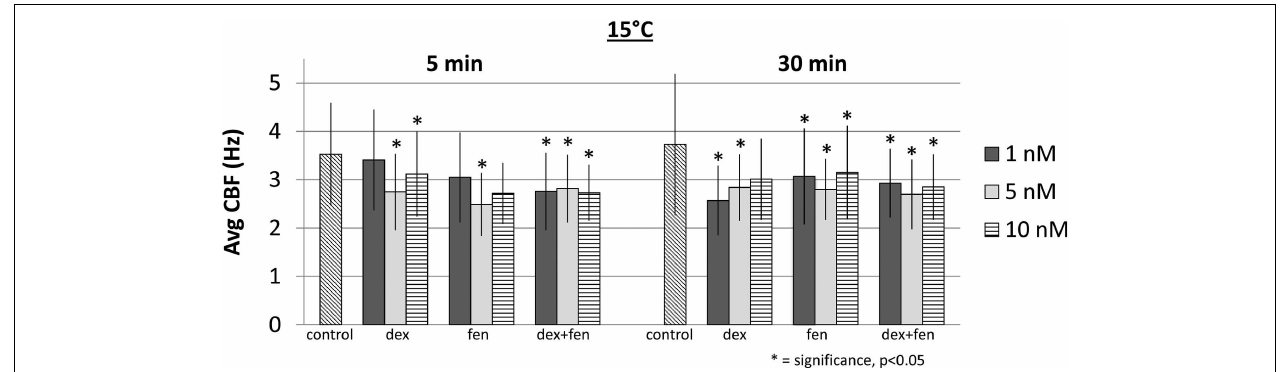
FIGURE 2 | Effects of drug exposure on ciliary beat frequency at 15°C .